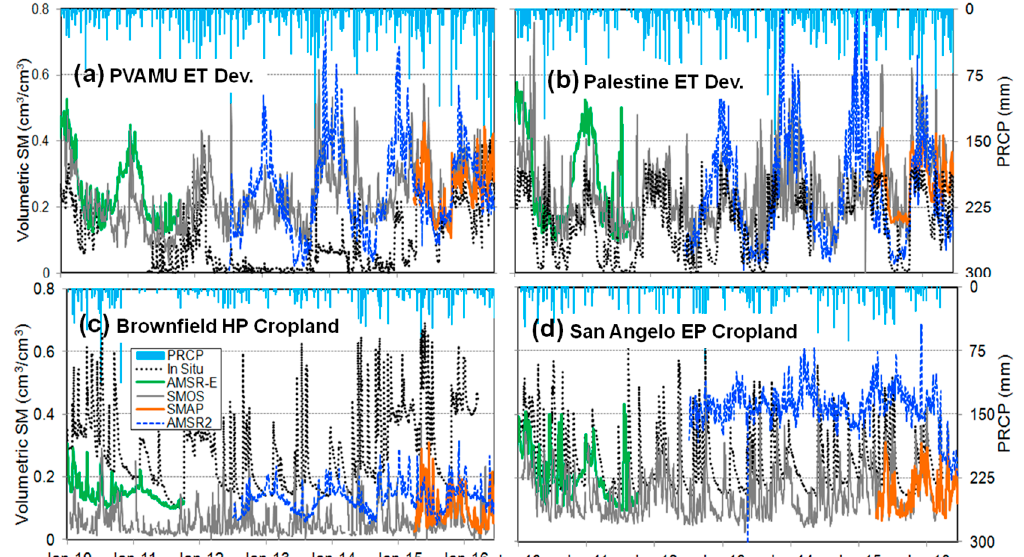
Figure 10. Comparison of satellite soil moisture data for Texas at four selected in situ stations and satellite grids during their overlapping periods (2010–2016). ET = East Texas; HP = High Plains; EP = Edwards Plateau and Dev. = Development.